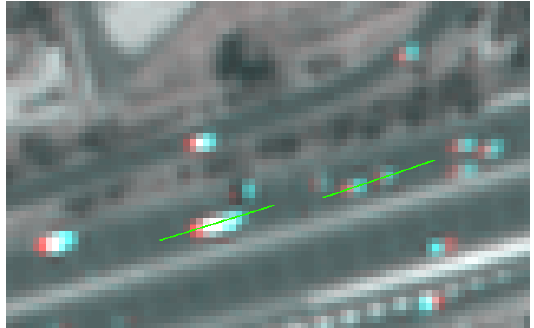
Figure 6: RapidEye focal plane assembly (FPA), g : gap between lines, D p : distance between packages, D ∗ : maximum distance between lines, D : distance red–green